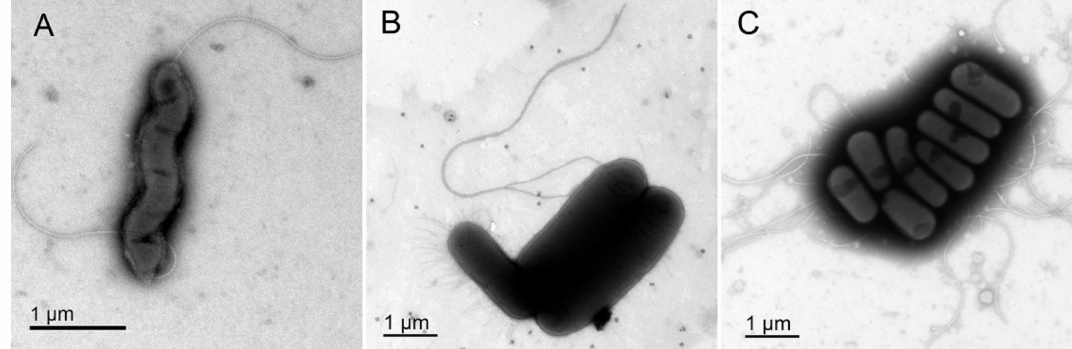
Figure 4. Representative transmission electron micrographs of the negatively stained control